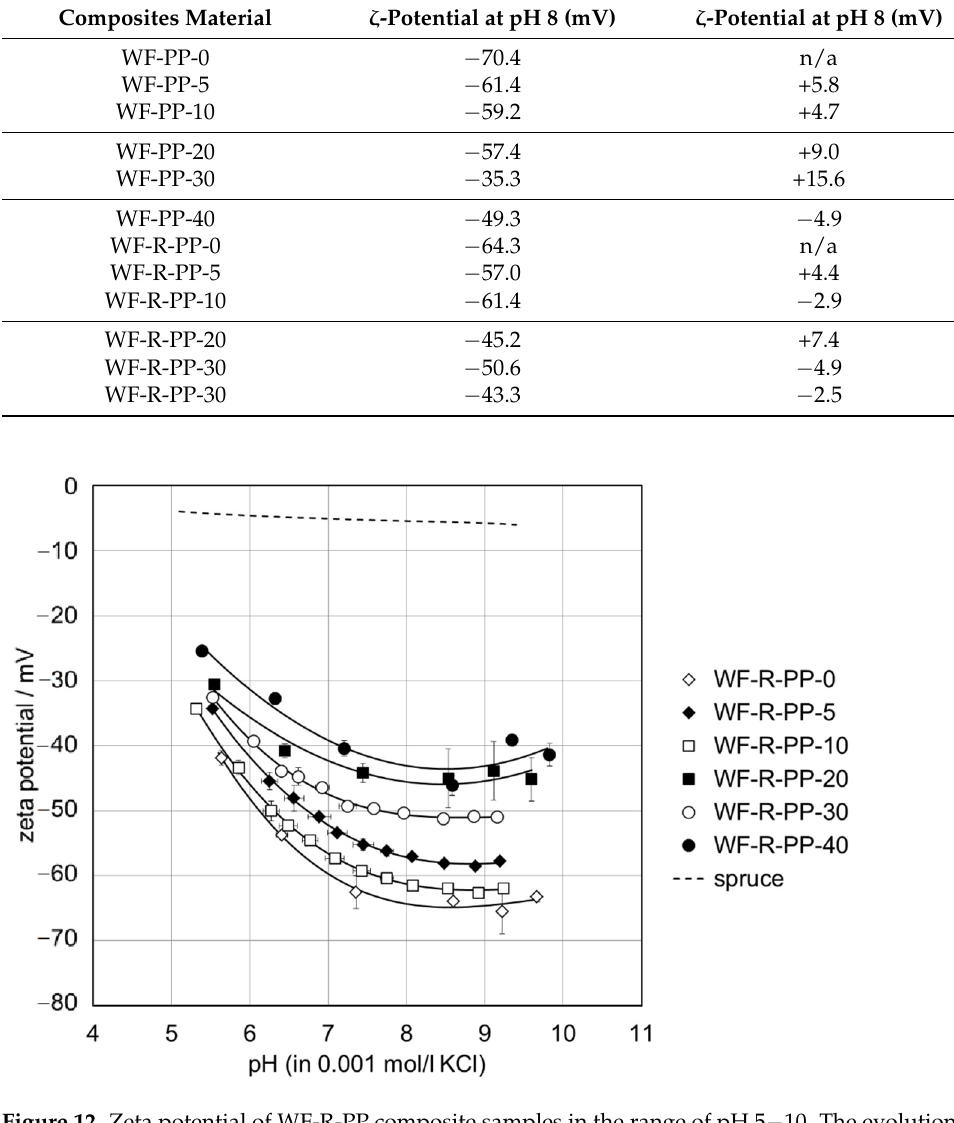
Figure 12. Zeta potential of WF-R-PP composite samples in the range of pH 5 − 10. The evolution of the zeta potential with pH for spruce as a representative softwood is shown for comparison. Table 2. ζ -potential for PP and R-PP-softwood fiber composites and deviation between measured and predicted results (assuming a weighted average of the zeta potential for PP and R-PP and spruce, respectively).